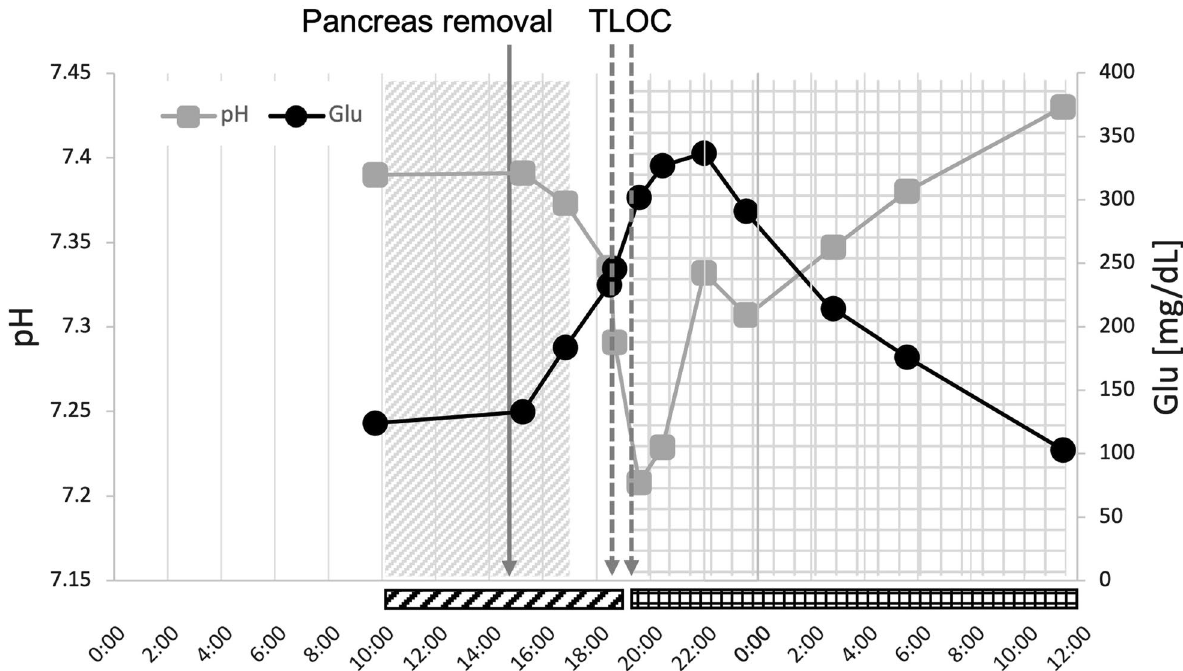
Fig. 2 The patient’s clinical course. The diagonally shaded area represents the operation time. The grid area represents the cannulation time. The diagonally shaded and grid rectangular areas below the x axis represent the intravenous fentanyl and insulin administration time, respectively. Glu glucose, TLOC transient loss of consciousness